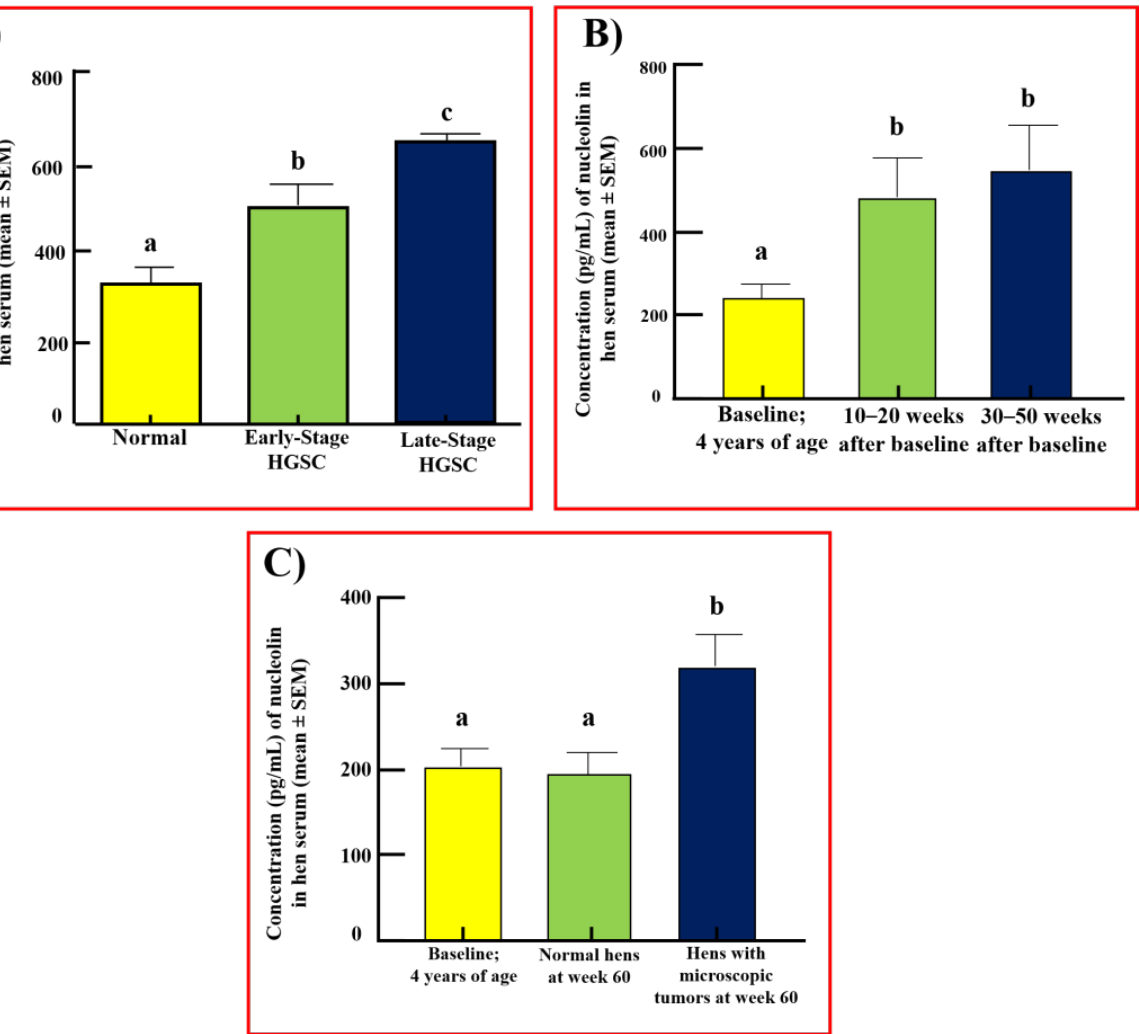
Figure 7. Changes in serum levels of nucleolin during HGSC development in hens. ( A ) Immunoassay showing serum levels of nucleolin (pg/mL, mean ± SEM) in hens with or without ( n = 6) HGSC at early ( n = 6) or late stages ( n = 6). Each bar represents serum levels of nucleolin in normal hens or hens with HGSC at early and late stages. Compared with normal hens, nucleolin levels in serum were significantly higher in hens with ovarian HGSC at an early stage ( p < 0.001) and increased further in late stages ( p < 0.0001). Bars with different letters are significantly different in serum nucleolin levels ( p < 0.001 for normal hens vs. hens with early-stage HGSC, and p < 0.0001 for normal hens vs. hens with late-stage HGSC). ( B ) Prospective study showing changes in serum levels of nucleolin during malignant transformation in hens that developed ovarian HGSC. Each bar represents serum levels of nucleolin in normal hens (baseline, immediately before monitoring), in hens at 10–20 weeks after baseline, and in hens at 30–50 weeks after baseline. Serum levels of nucleolin progressively increased in hens from baseline to 10–20 weeks of monitoring ( p < 0.05) and further at weeks 30–50 of monitoring ( p < 0.01) (baseline vs. 10–20 weeks after baseline p < 0.05; baseline vs. 30–50 weeks after baseline p < 0.01). ( C ) Hens that showed no apparent tumors at gross diagnosis were classified as normal or microscopic tumors at week 60 based on H&E staining. Healthy hens showed no change in nucleolin expression while hens with microscopic tumors showed an increase in serum levels of nucleolin ( p < 0.05). Bars with different letters are significantly different in serum nucleolin levels, and bars with the same letter are not significantly different in serum nucleolin lev- els.